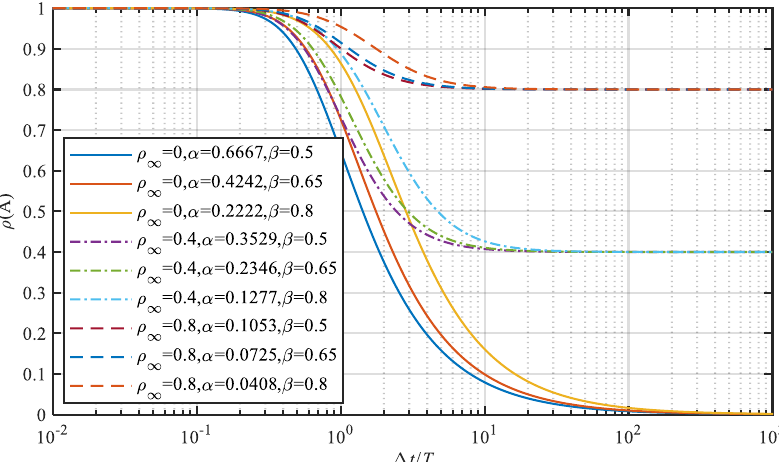
Figure 1. The spectral radius of transfer matrix of the proposed method with different numerical damping.